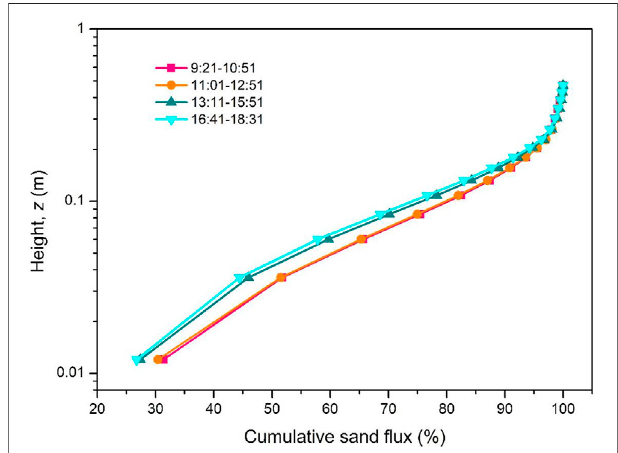
FIGURE 6 | Variation of the cumulative sand fl ux with height above the gobi surface atop the Mogao Grottoes during the transport event 20130417 (Tan et al.,